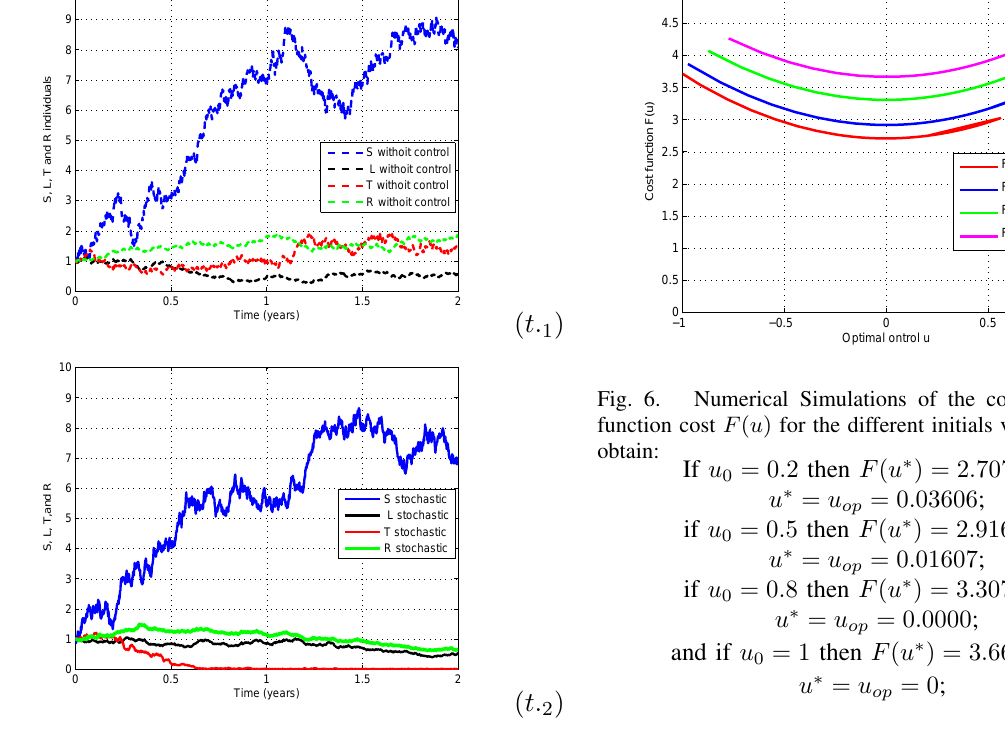
Fig. 5. Trajectories without and with control of the model (1). For Λ = 5 , β T = 0 . 08 , τ = 0 . 08 , u 0 = 0 . 08 , X 0 = (1 , 1 , 1 , 1) .